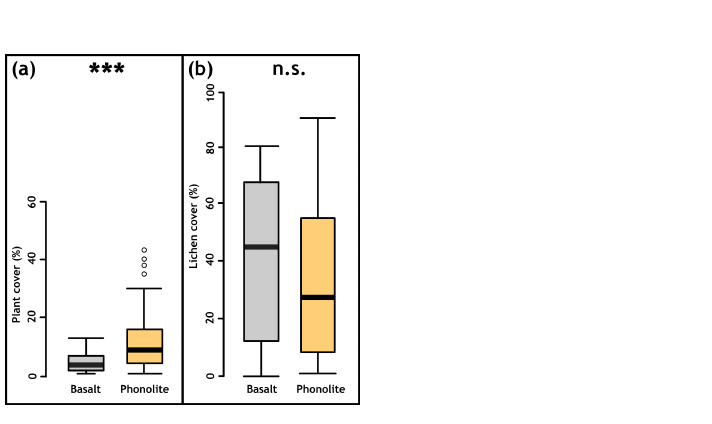
Figure A2. Vegetation cover on basaltic and phonolite plots. (a) Plant cover showed significant differences between the substrates ( p < 0 . 001, Mann–Whitney U test) and (b) lichen cover showed no significant differences between the substrates ( p > 0 . 05, Mann–Whitney U